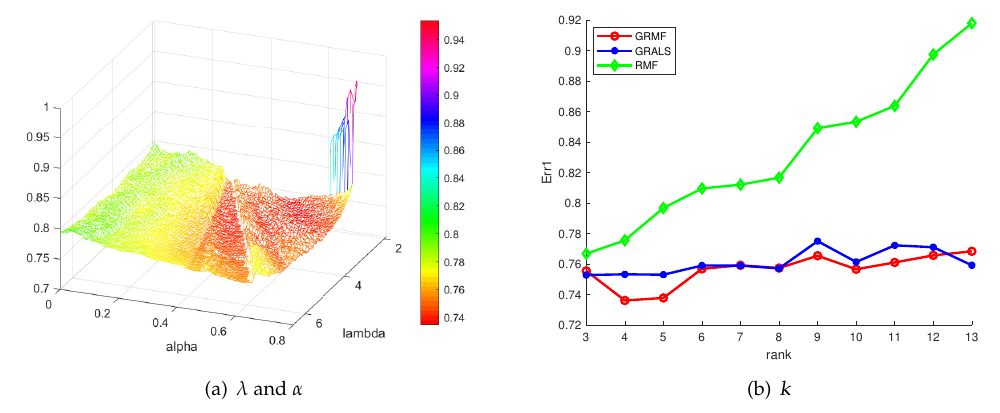
Figure 3. The effects of the parameters of GRMF on the